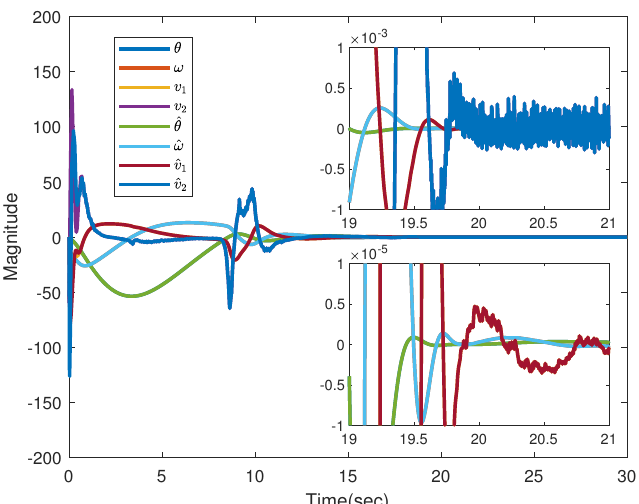
Figure 9. Convergence of the states of the system (23) and the estimates produced by observer (16) to the origin in the presence of deterministic disturbances and stochastic noises.